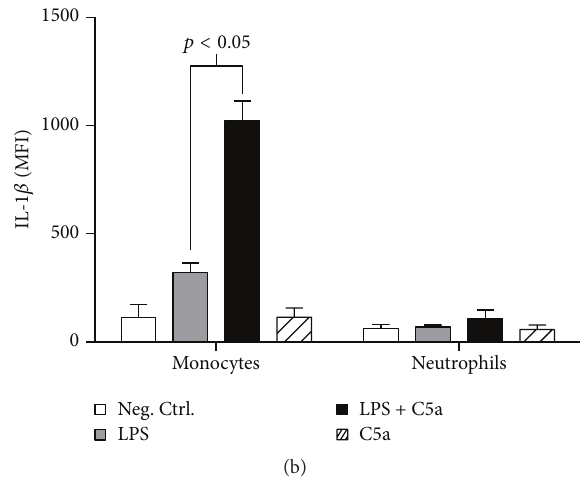
Figure 3: C5a robustly enhances TLR4-mediated IL-1 𝛽 production in bone marrow inflammatory monocytes but not neutrophils. 1 × 10 6